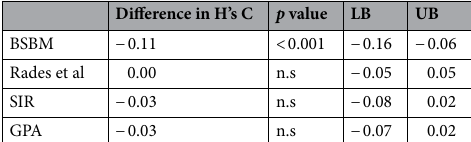
Table 2. Pairwise comparisons of Harrell’s C to